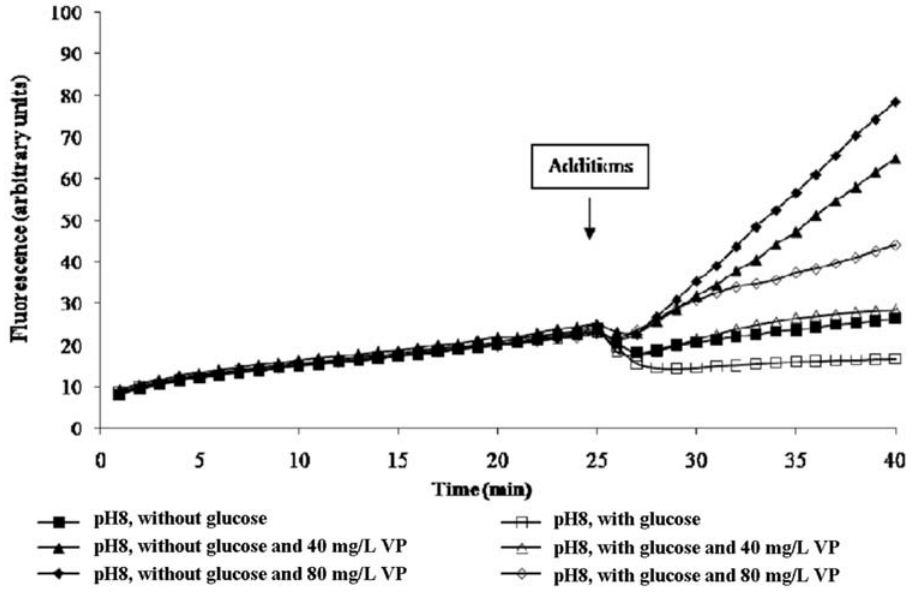
Figure 6. The effects of concentrations of verapamil (VP) on the efflux of EB by AG100 at pH 8.